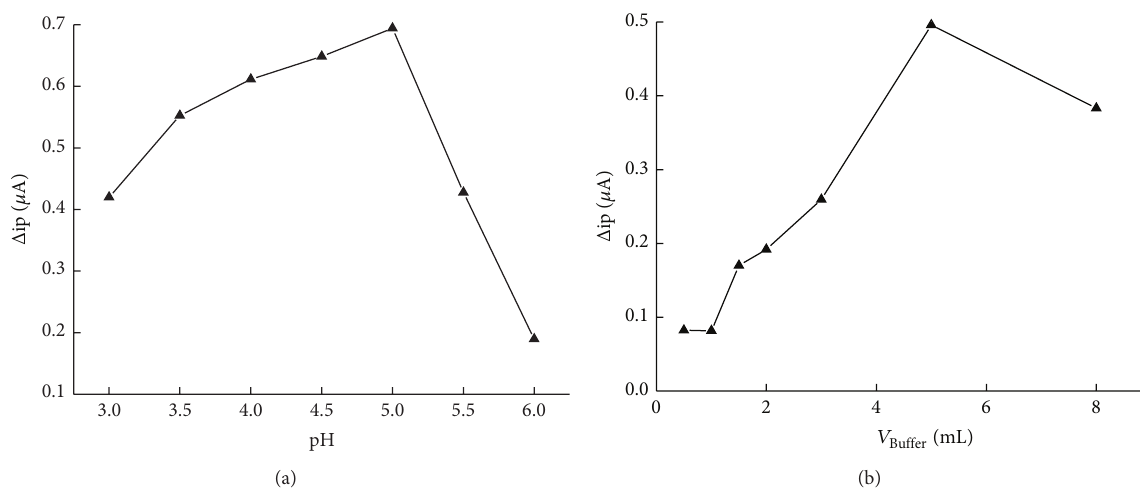
Figure 4: Effect of pH and the volume of buffer on the cyclic voltammograms of the interaction system.